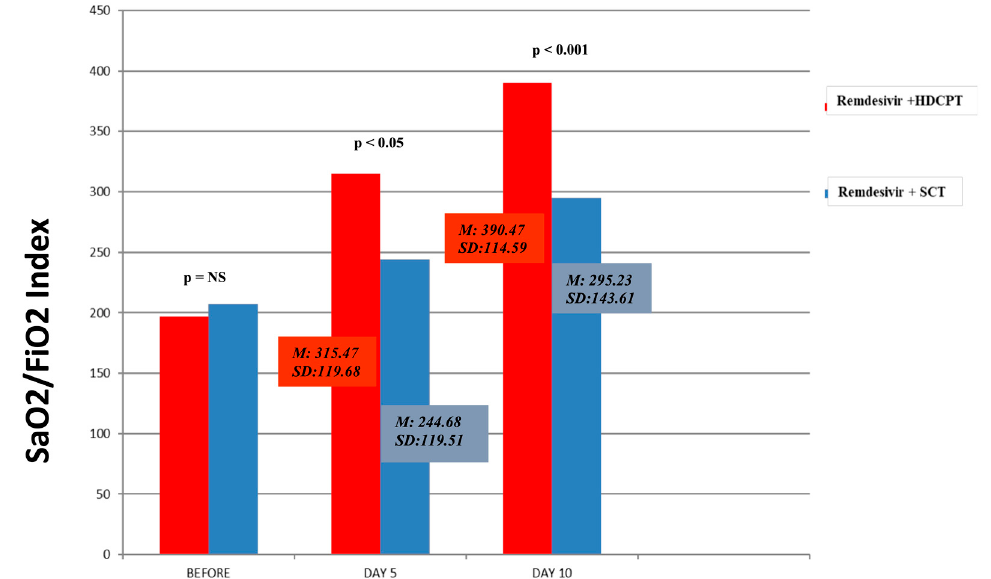
Figure 2. Mean SaO2/FiO2 index before and after 5 and 10 days of therapy in the remdesivir + HDMPT and remdesivir + SCT groups. Abbreviations: SCT: standard corticosteroid therapy; HDCPT: high-dose corticosteroid pulse therapy.